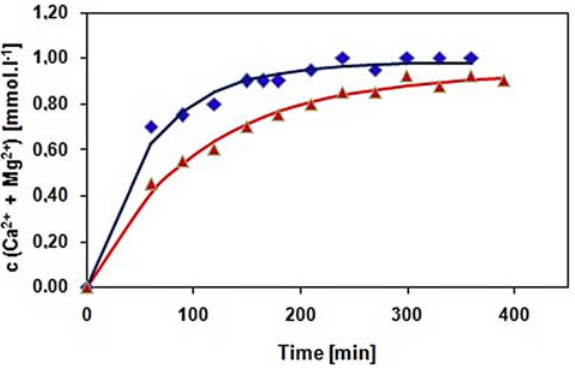
= 0.09 L · min –1 ): ( (cid:2) ) CO2